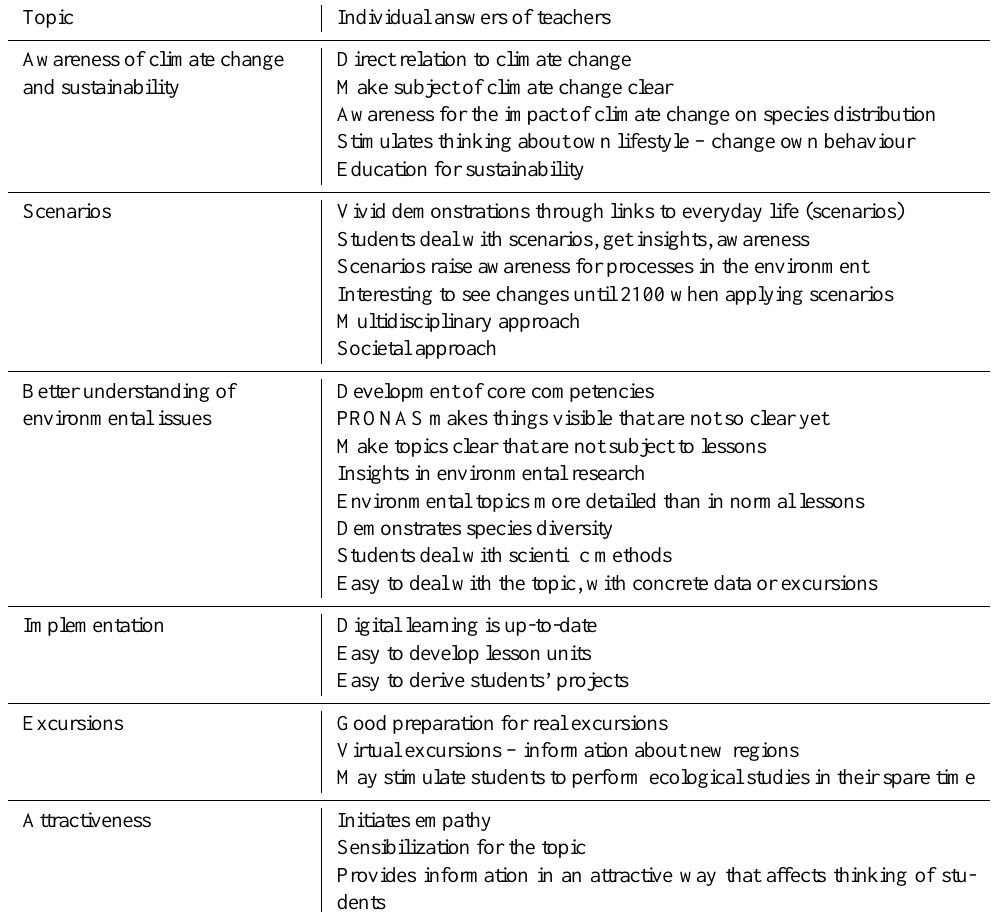
Table 2. Feedback of 15 teachers about the benefits of